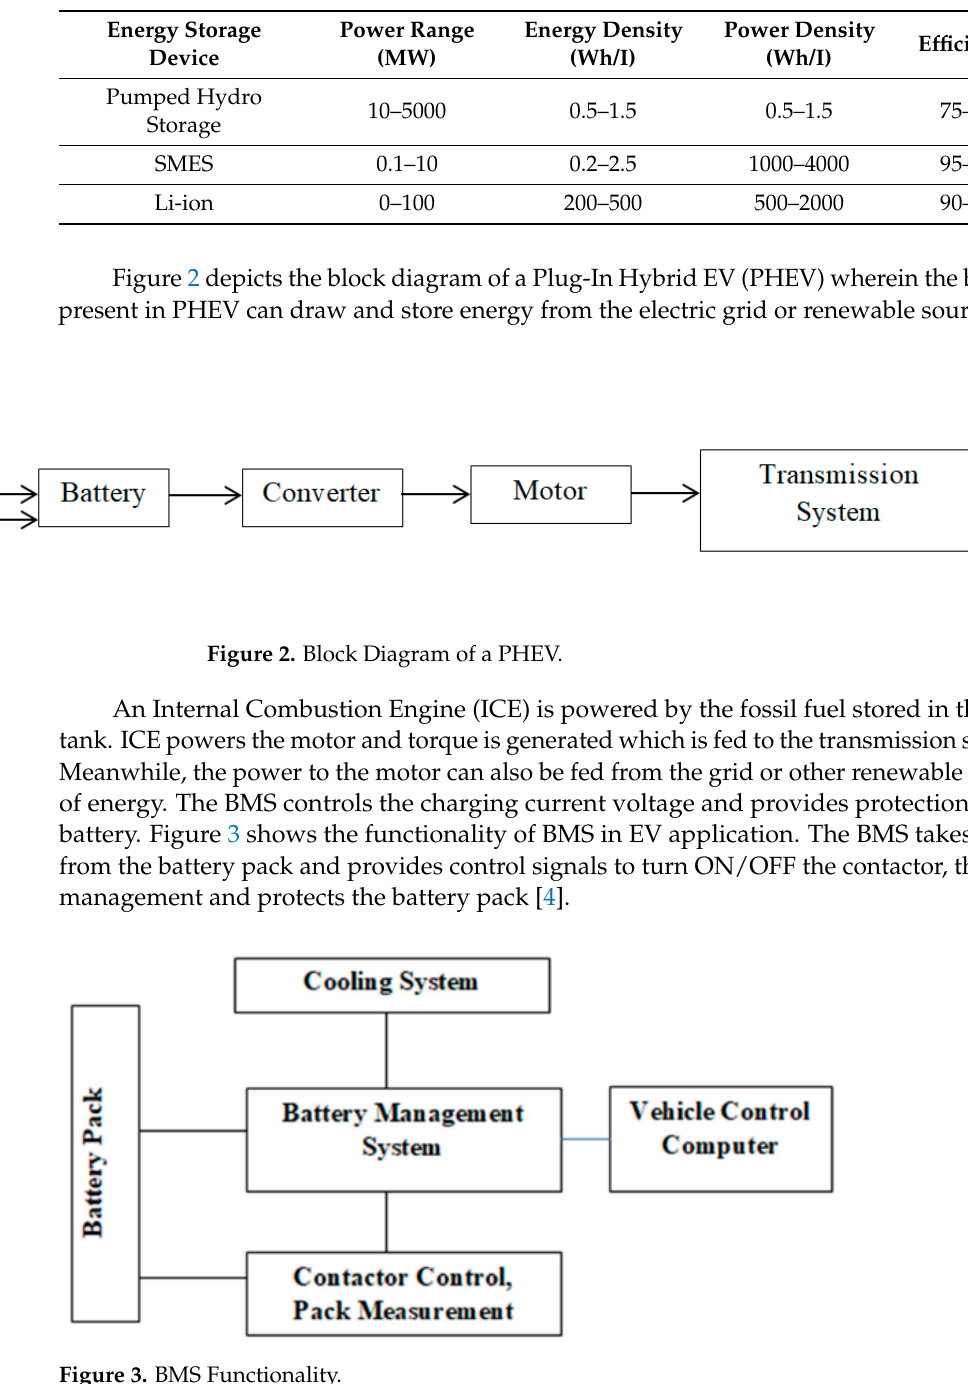
Table 1. Comparative analysis of various energy storage devices.